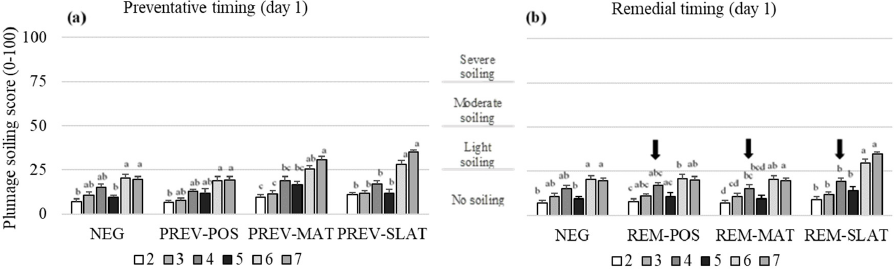
Figure 5. Mean plumage soiling scores (raw means ± SEM) of birds that received ( a ) preventative provision of the flooring treatments (PREV) ( b ) or birds that received remedial provision of the flooring treatments (REM): negative control (NEG (presented twice)), clean litter (POS), iodine mat (MAT),